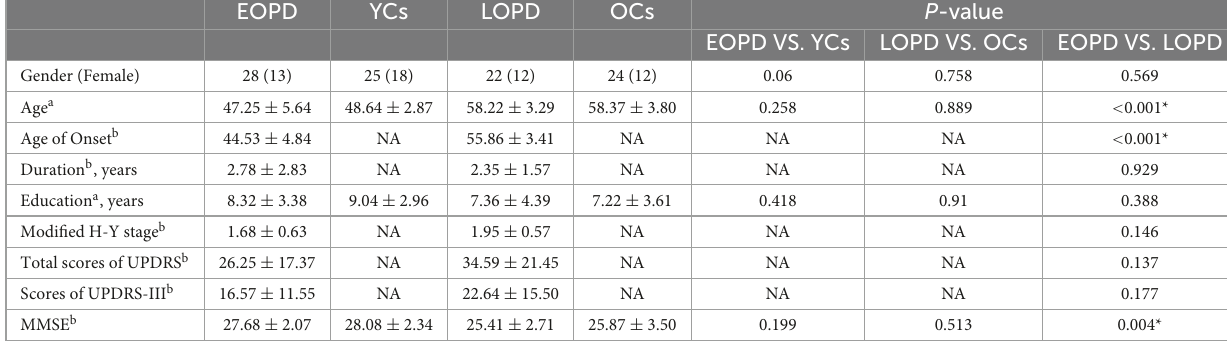
TABLE 1 Demographic and clinical information of patients with Parkinson’s disease and healthy